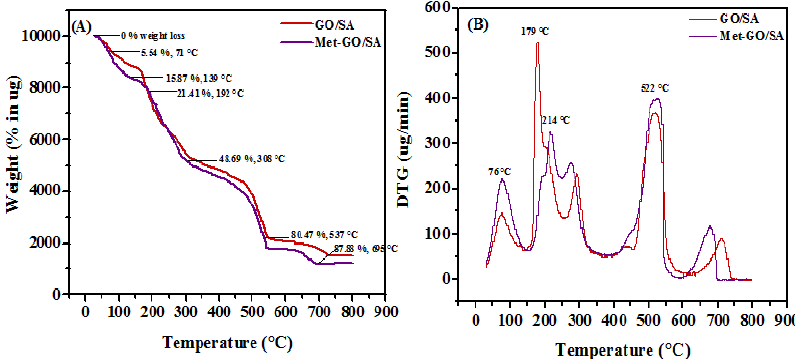
Figure 6. Thermal analysis curve ( A ) TGA ( B ) DTG for GO/SA and Met-GO/SA.